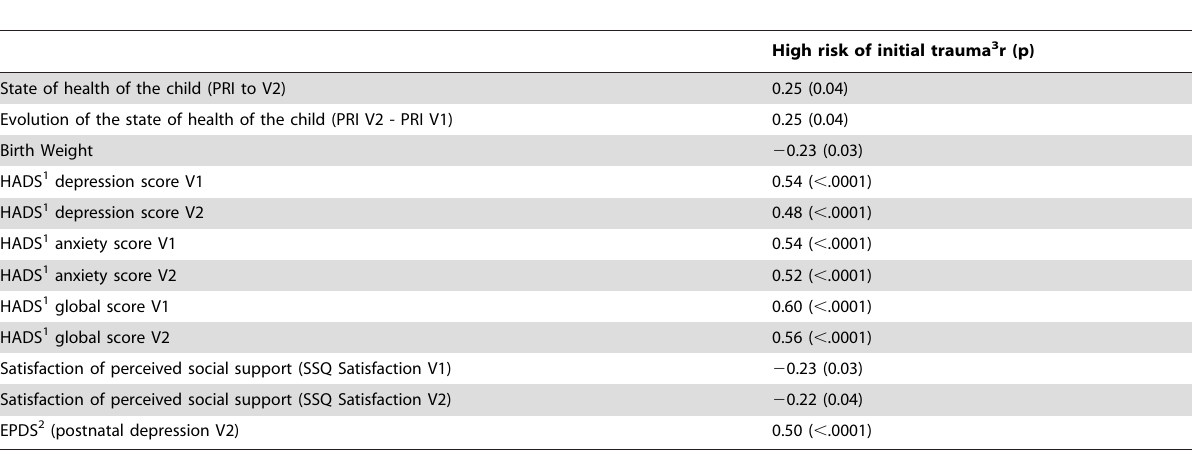
Table 3. Mothers’ and babies’ clinical characteristics and the high risk of maternal trauma.